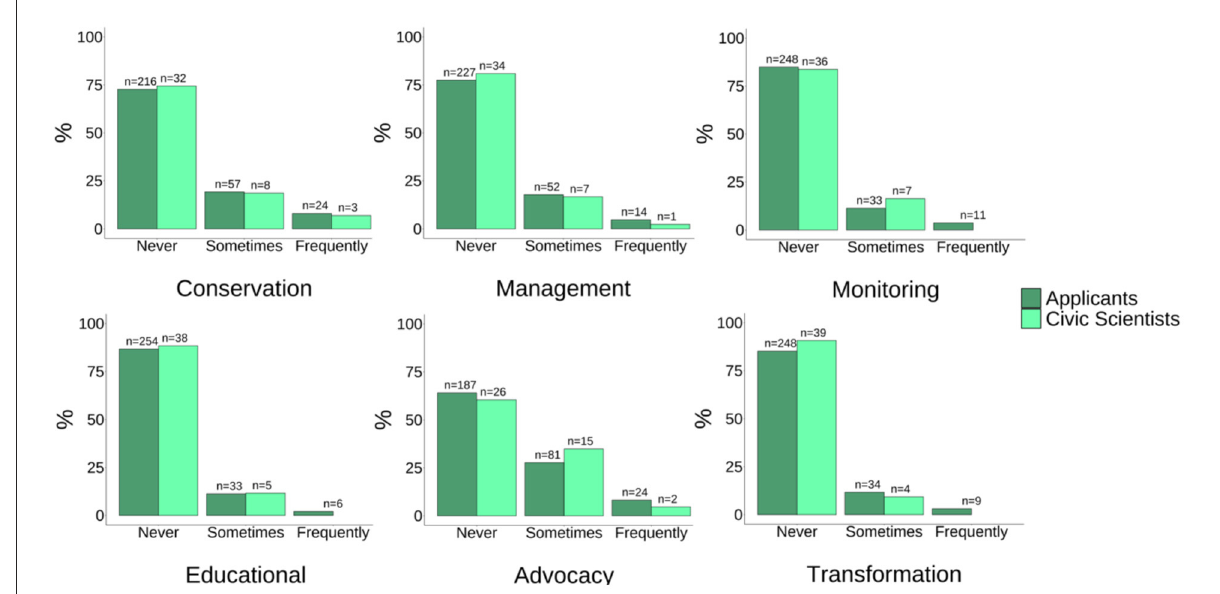
FIGURE2 Prior stewardship experiences of the applicants and civic scientist.